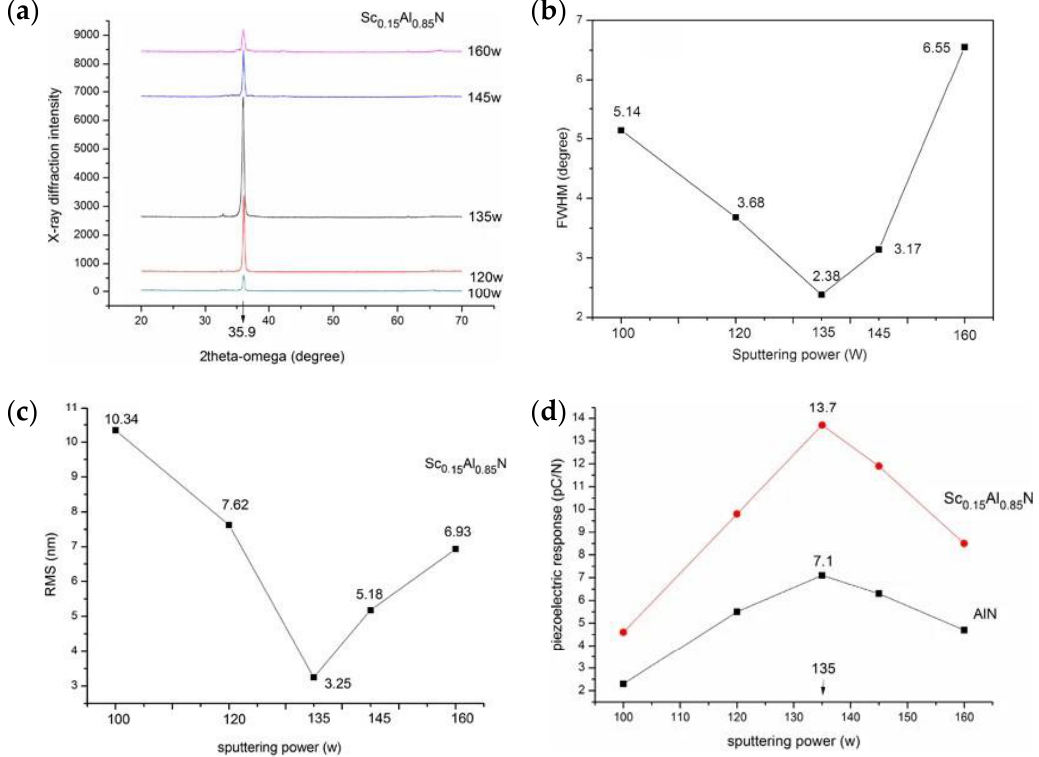
Figure 5. Effect of sputtering power on ( a ) XRD intensity, ( b ) FWHM, ( c ) RMS, and ( d ) piezoelectric response. Reproduced with permission from Ref. [26].